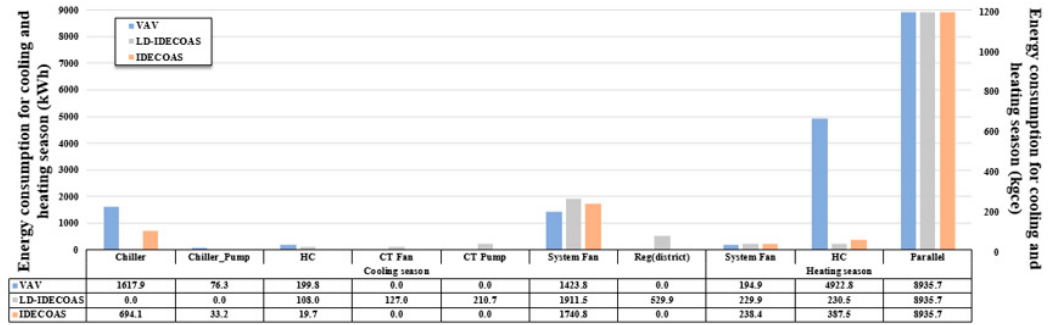
Figure 14. The seasonal energy consumption comparison in Urumqi.